Question: In one sentence, what is this figure communicating?
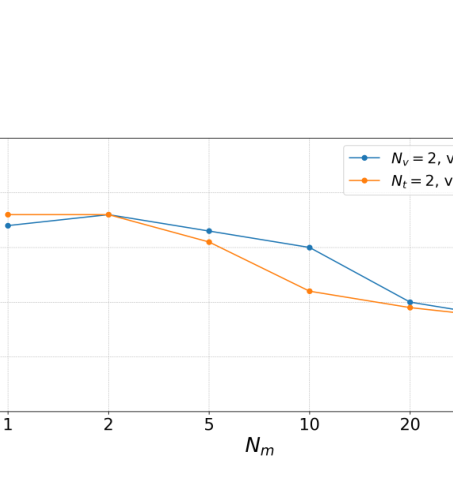
Answer: Performance with different numbers of LQs.